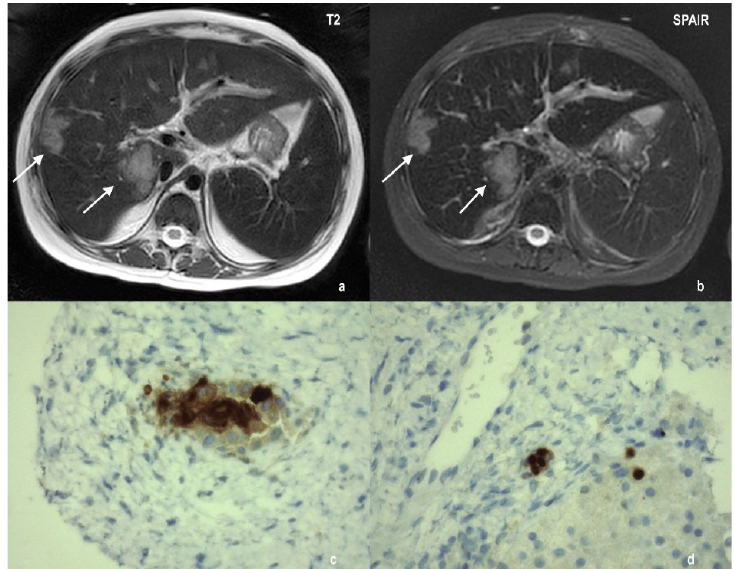
Figure 3. Radiological and histological presentation of adenoviral hepatitis. Liver MRI shows multiple parenchymal lesions (indicated by the white arrows), hyperintense in T2 weighted sequences (panel ( a ): axial T2; panel ( b ): axial SPAIR). Immunohistochemical staining for adenovirus makes evident the presence of HAdV in hepatocytes (panels ( c , d )).